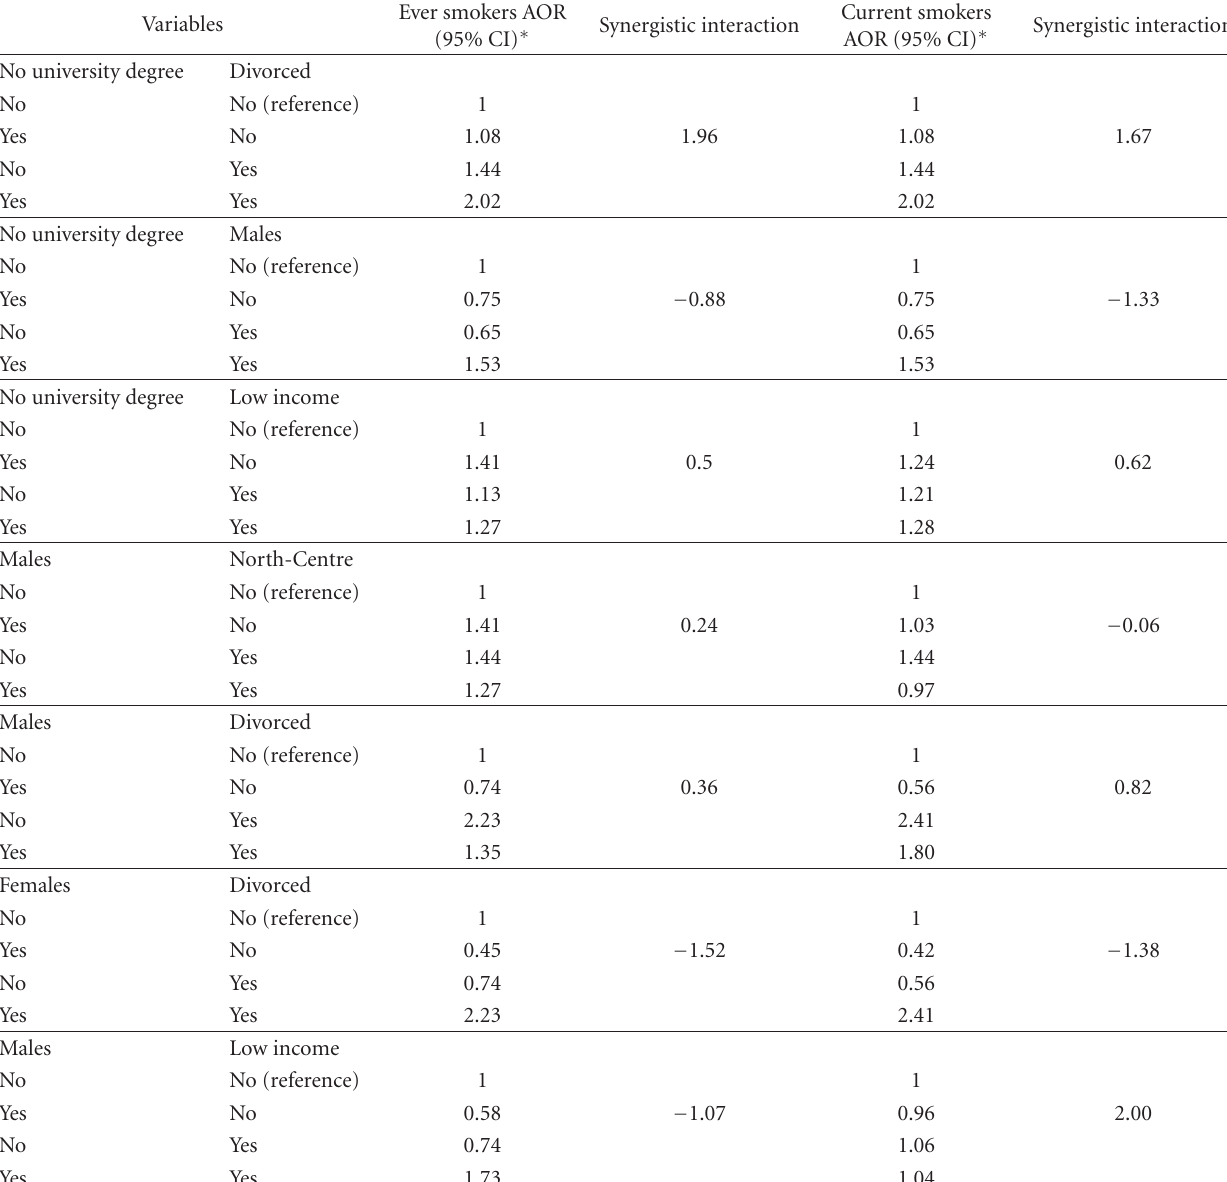
Table 4: Synergistic interaction between Sociodemographic variables in influencing ever and current